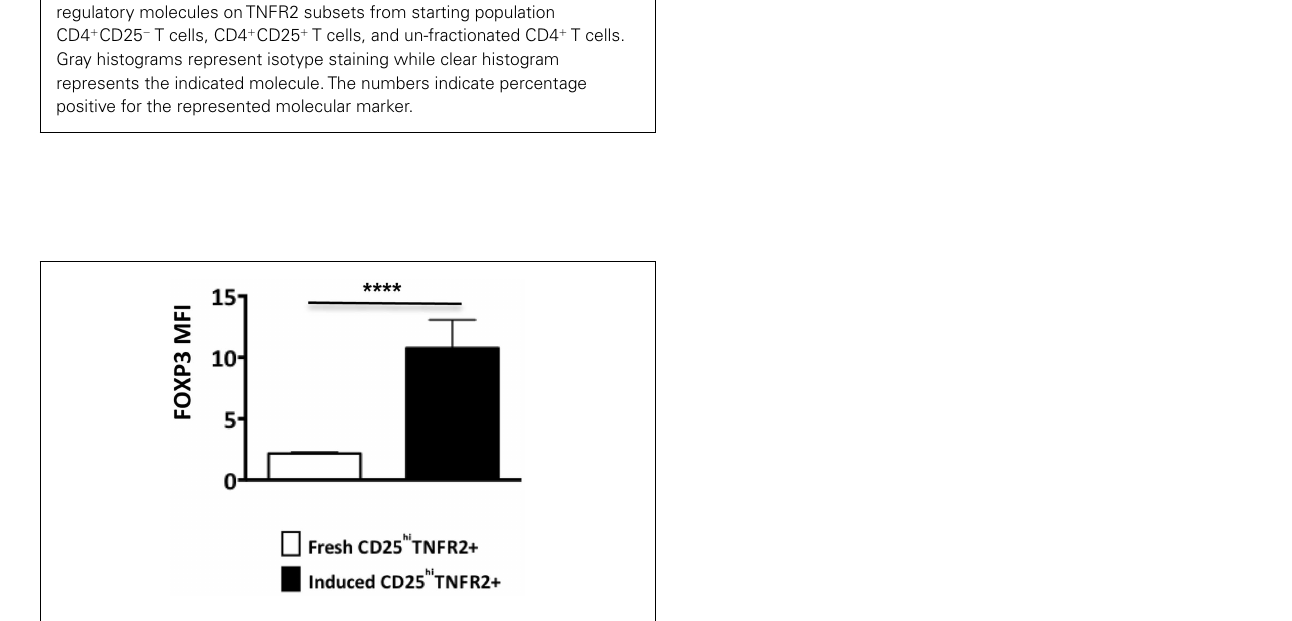
FIGUREA2 | FOXP3 expression levels on ex vivo and inducedTNFR2 + T cells .The FOXP3 expression levels were compared between ex vivo CD25 hi TNFR2 + and induced CD25 hi TNFR2 + T cells. Unpaired Student’s t -test was performed to compare FOXP3 levels and graphs represent mean ± SEM. ** p < 0.01.